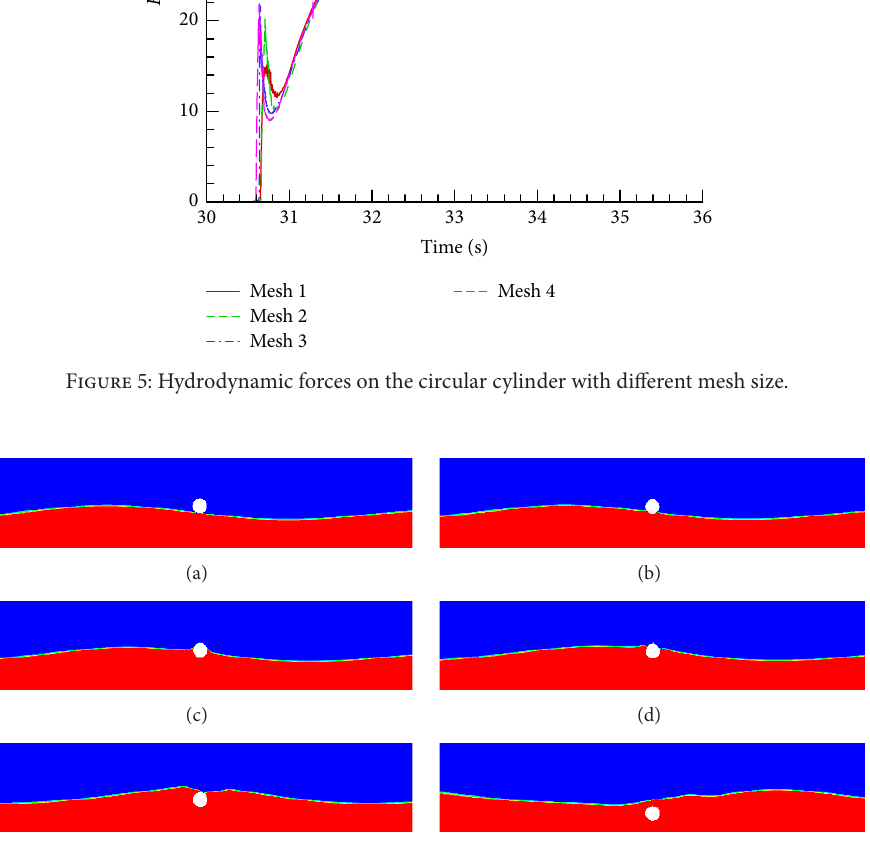
where 𝐹 is the vertical hydrodynamic force, 𝑉 is the relative velocity between the cylinder and wave surface, and 𝑅 is the radius of the